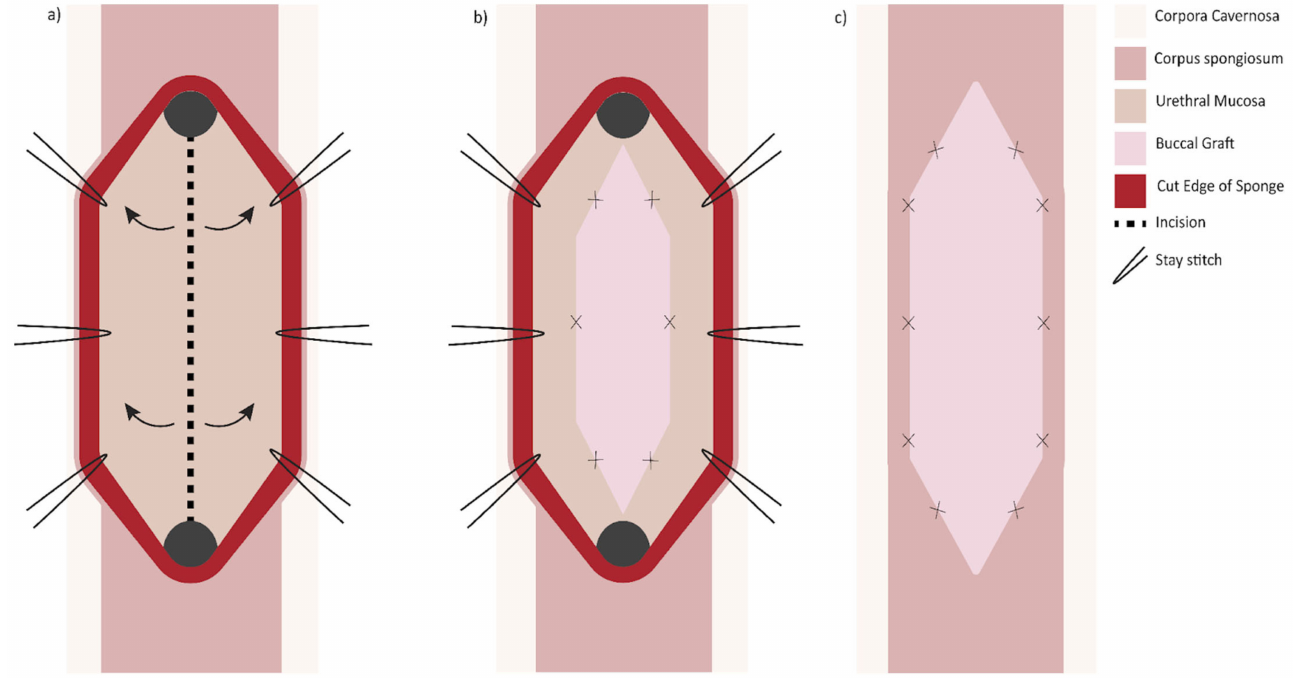
Figure 3. Double graft technique, ventral approach: ( a ) the ventral surface of the urethra is opened and incision made in the dorsal mucosa; ( b ) a buccal graft is sutured in the dorsal defect; ( c ) the ventral urethrotomy is closed with the aid of a second buccal mucosa